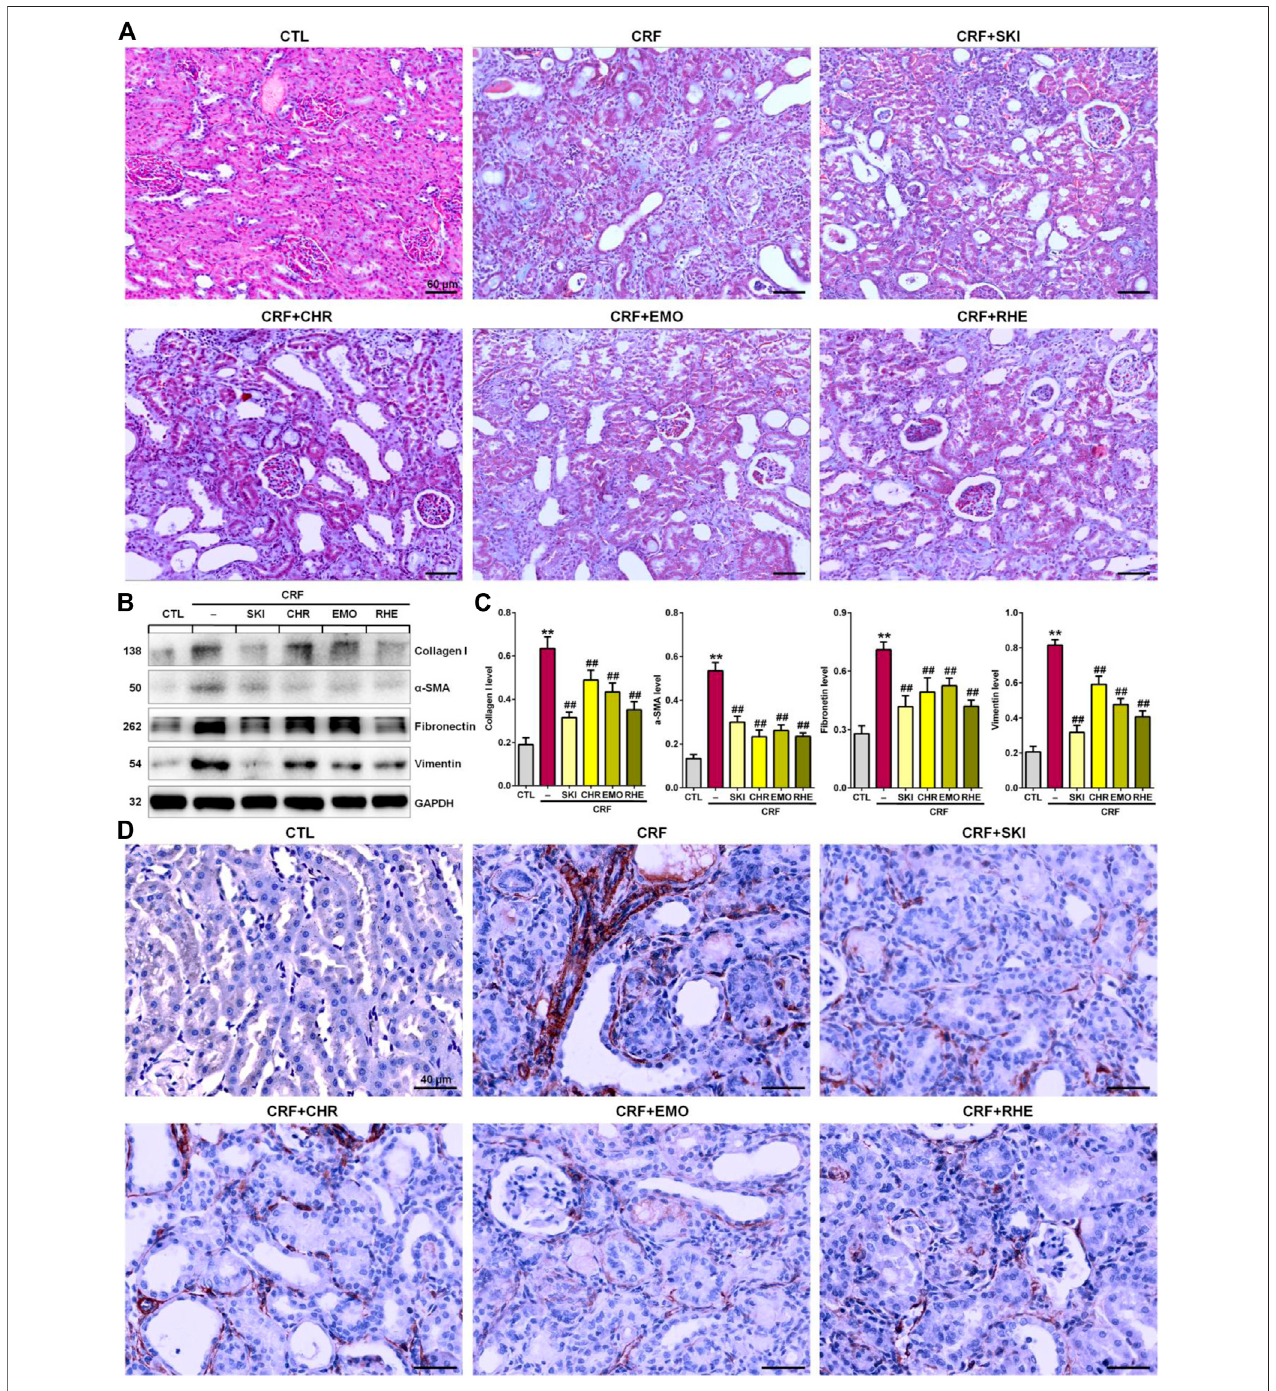
FIGURE 2 | SKI and three anthraquinones including chrysophanol, emodin, and rhein ameliorated renal fi brosis in the adenine-induced CRF rats. (A) Images of Masson ’ s Trichrome staining of the kidney tissues in the different groups. Scale bar, 60 μ m. (B) Expressions of pro fi brotic proteins including collagen I, α -SMA, fi bronectin, and vimentin of the kidney tissues in the different groups. (C) Quantitative analysis of pro fi brotic protein expressions of the kidney tissues in the different groups. ** p < 0.01 compared with the CTL group; ## p < 0.01 compared with the CRF group. (D) Immunohistochemical analysis with anti – α -SMA of the kidney tissues in the different groups. Scale bar, 40 μ